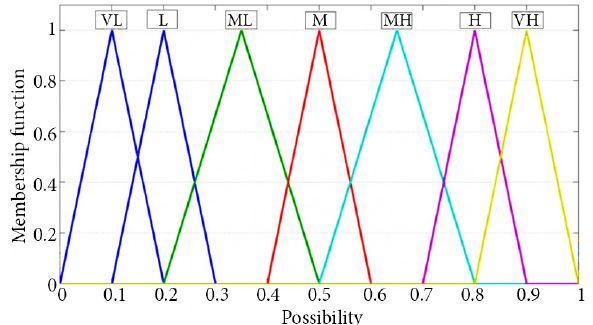
Figure 3. The membership function graphs for determining the probability of basic